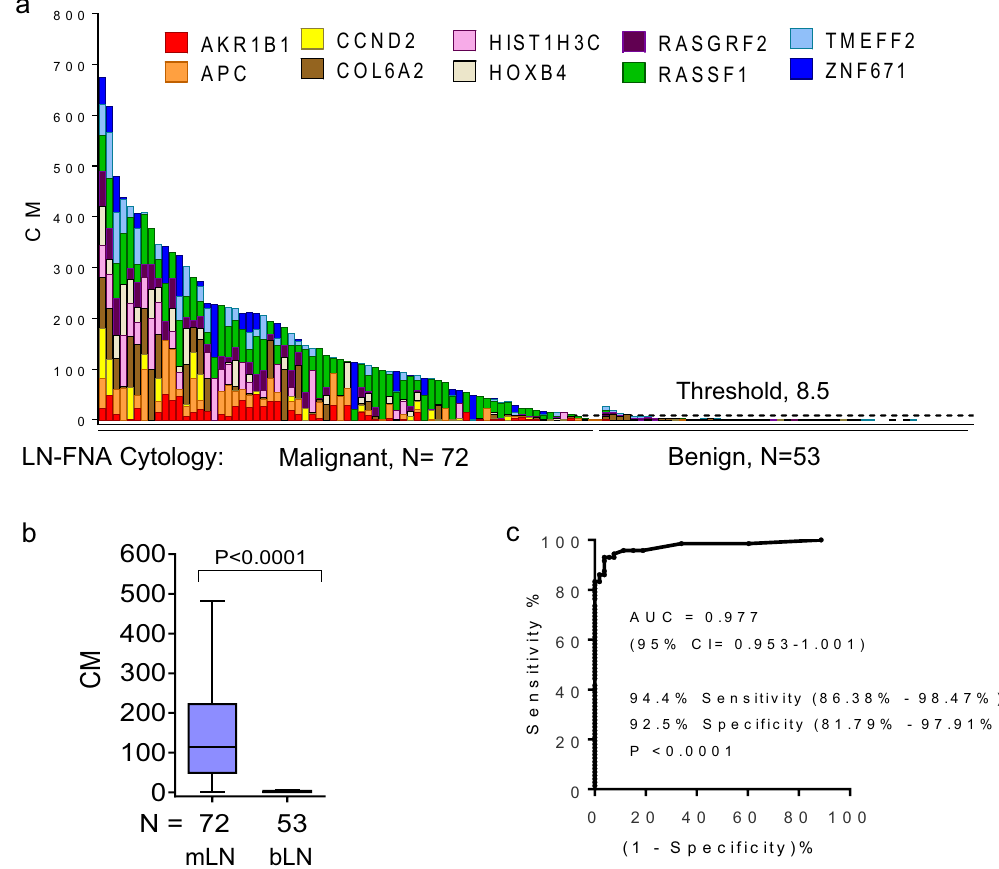
Fig. 3 Pilot clinical validation of the automated BCDA on FNA samples collected prior to neoadjuvant chemotherapy. The results of BCDA were compared to cytology-based diagnosis of the FNA. a Histogram shows the 10-gene marker panel distinguished between malignant ( N = 72) and benign ( N = 53) FNA samples collected in the outpatient clinic using a threshold set for benign at 8.5 CM based on the prospective study (Fig. 2). b Box plot shows that cumulative methylation is signi fi cantly higher in malignant compared to benign breast LN-FNA. Mann – Whitney P values are shown. For the box plot, the whiskers are Tukey, the box is 25th and 75th percentiles, and the center bar is the median. c ROC: AUC analysis shows the discriminatory power of the 10-gene marker panel. BCDA performed with a sensitivity of 94.4%, and a speci fi city of 92.5%, and ROC, AUC: 0.977 (95% CI: 0.953 – 1.00). FNA fi ne needle aspiration, N number of